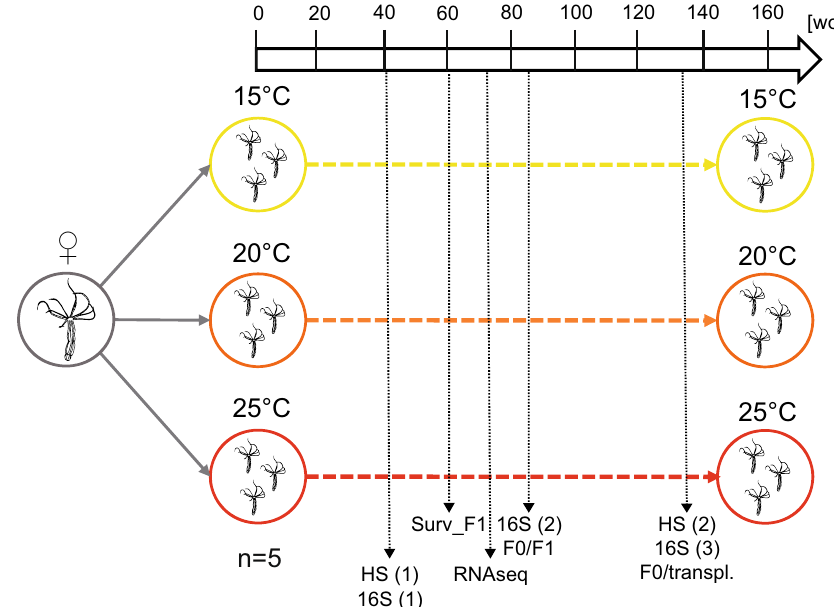
Fig. 1 Experimental setup. A single female polyp from the standard culture conditions (16 ‰ , 20 °C) was isolated and propagated via clonal reproduction. When a total of 150 clones was reached, they were split into 15 different culture boxes of 10 animals each. The boxes were put at three different acclimation temperatures (ATs) (15, 20, and 25 °C, n = 5) and the number of animals/box was kept equal to 50. Heat stress experiments (HS) (6 h, 40 °C) were performed at 40 ( n = 10) and 132 ( n = 5) weeks of acclimation (woa). Sexual reproduction was induced at 60 and 84 woa for the juvenile survival test (Surv_F1, n = 10) and the vertical transmission experiment (F0/F1, n = 5). At 40, 84 and 132 woa samples were collected for 16S sequencing (16S, n = 5); at 76 woa sampling for RNA sequencing was performed ( n = 5).